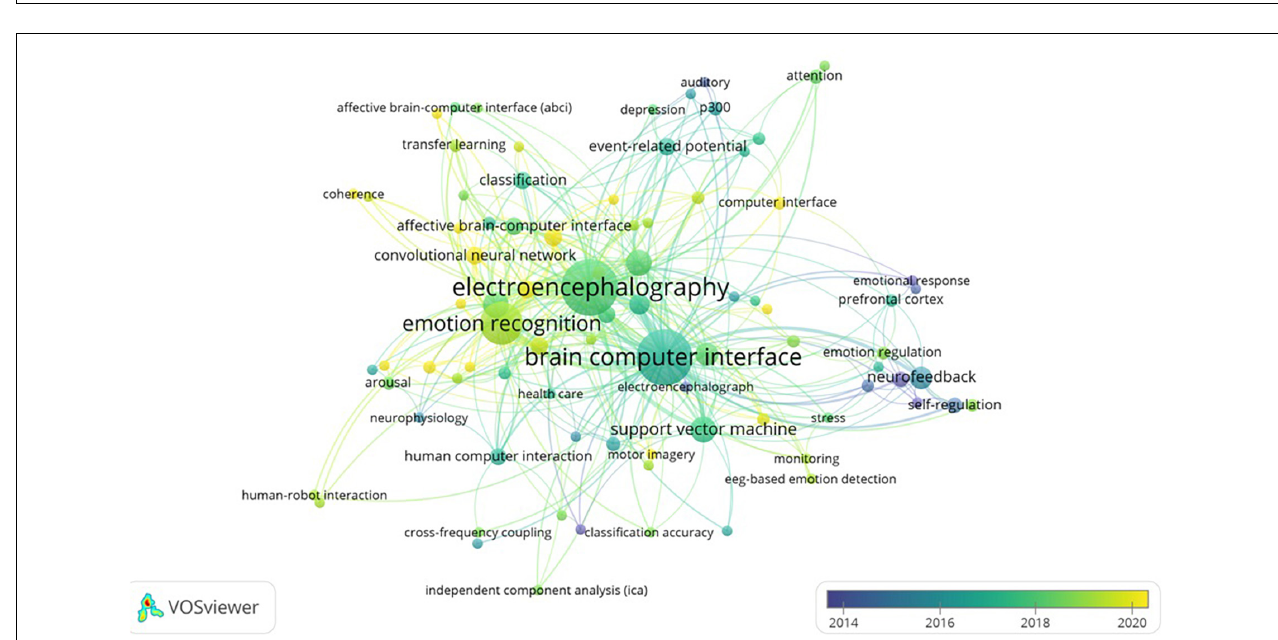
FIGURE 5 | Keywords co-occurrence analysis in BCI and emotions research.